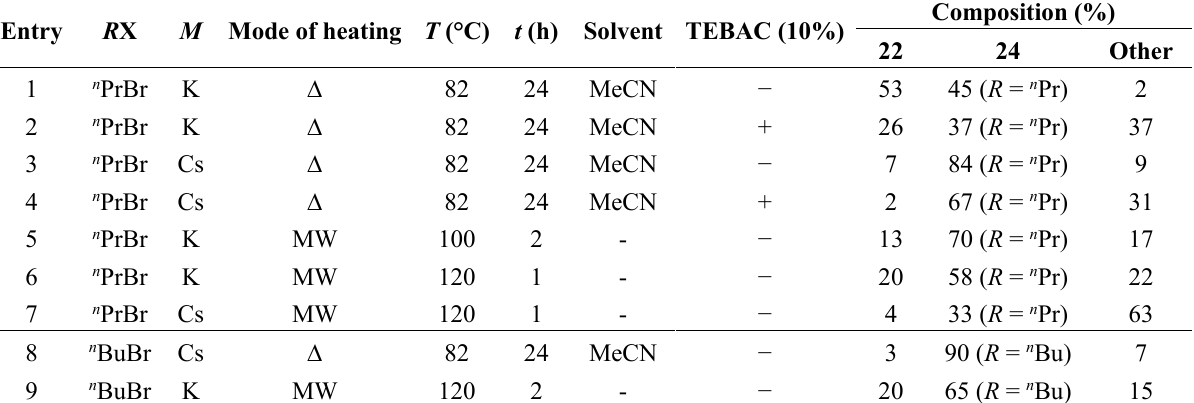
Table 6. The alkylation of diethyl cyanomethylphosphonate ( 22) under thermal and MW